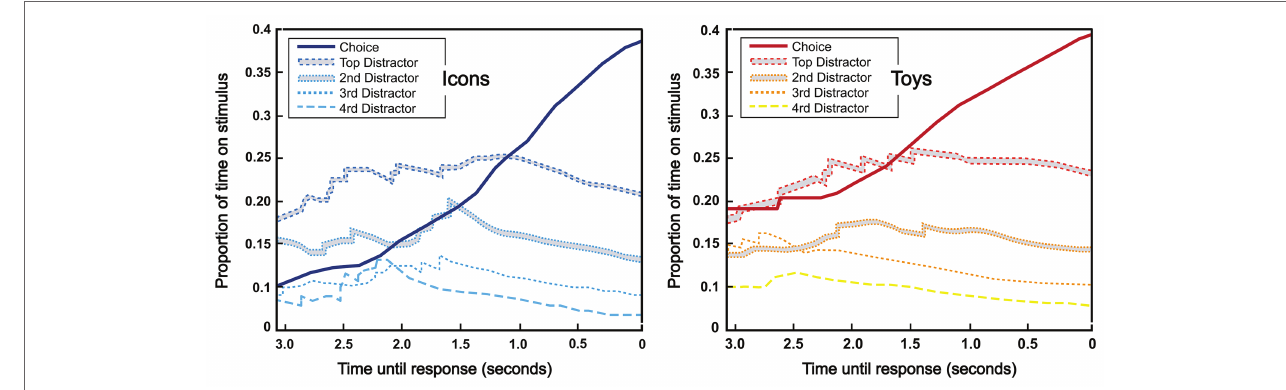
FIGURE 7 | Plots of the proportion of time extracted by chosen stimulus or distractor stimulus by eye-tracking (ranked by total fixation time). Plot result for icons choice and distractor (left) and plot result for toys choice and distractor